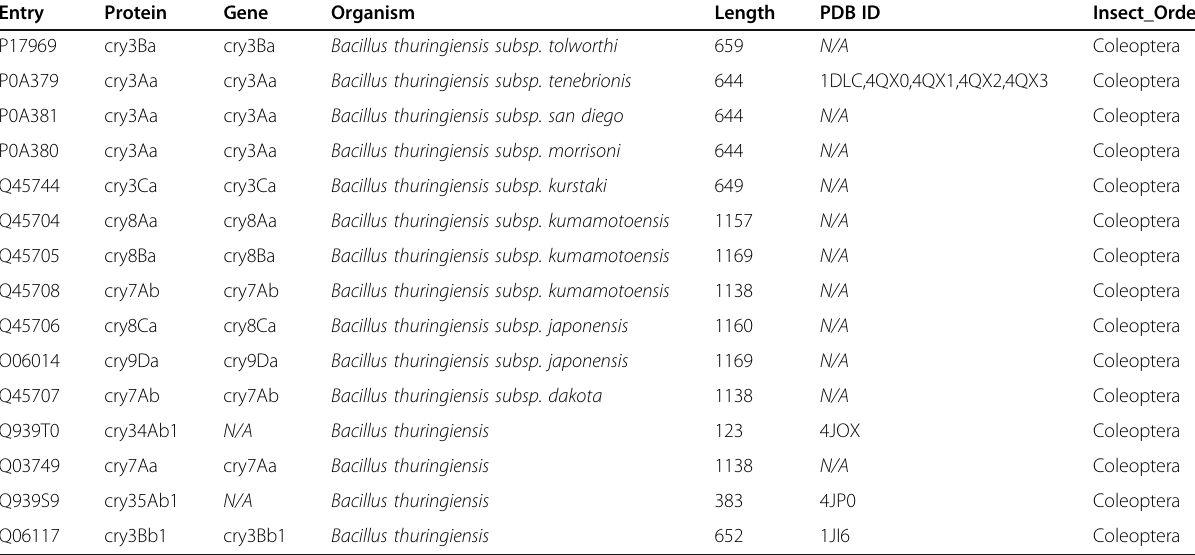
Table 1 List of cry proteins having toxicity for Coleoptera insect order